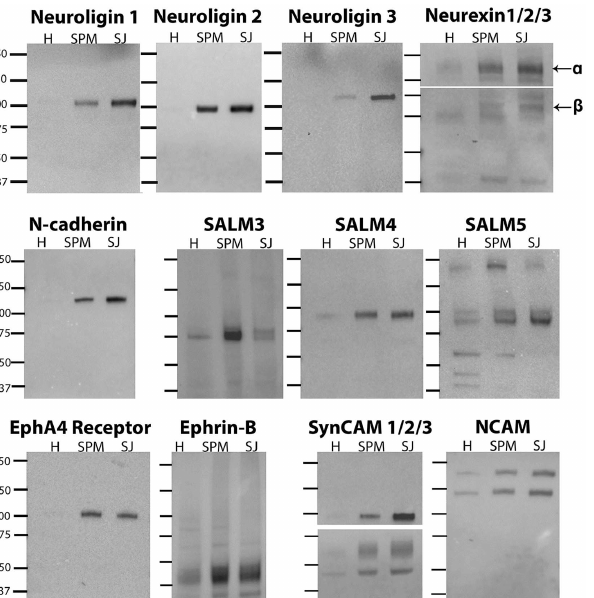
Fig 5. Some cell adhesion molecules are enriched in the SJ fraction, suggesting selectivelocalization at the synaptic cleft. Western immunoblots comparing synaptic junction(SJ) fractions and parent homogenate (H) and synapticplasma membrane(SPM) fractions. The lower portion of neurexin immunoblot and the upper portion of SynCAM 1/2/3 immunoblot correspondto higherexposuretimes to allowoptimal visualizationof all isoforms. Certain proteinsincludingneuroligins, neurexins, N-cadherin, SynCAM 1 and SALM5 show distinctive enrichment. Equal amounts of protein were loadedinto each lane. Experiments were repeatedat least twice using different SJ fractions, with similar results (S2